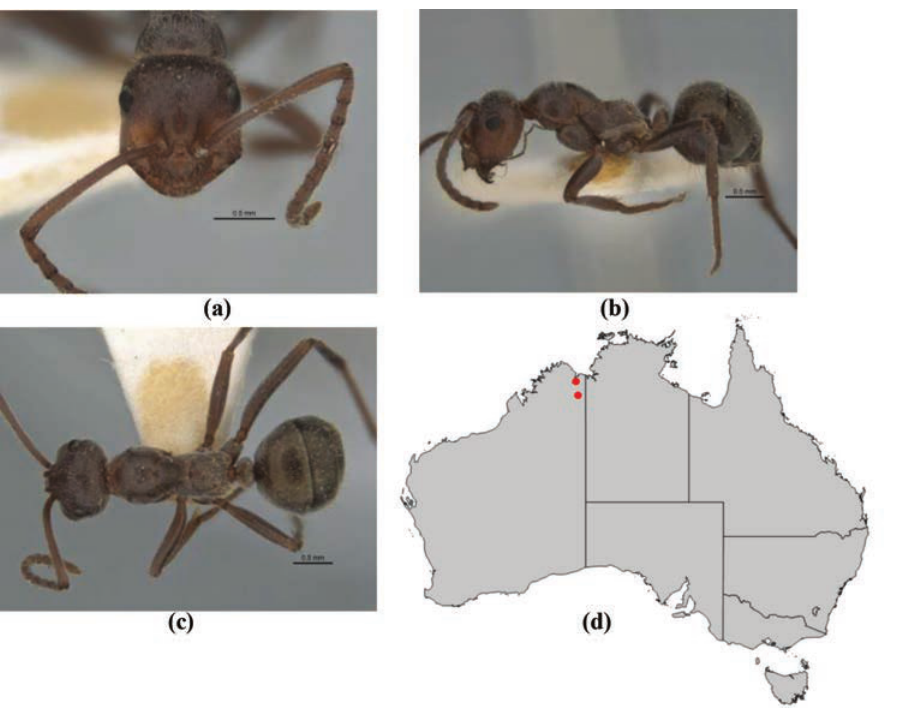
Figure 14. Melophorus griseus sp. n.: minor worker holotype (JDM32-004555) frons ( a ), profile ( b ) and dorsum ( c ); distribution map for the species ( d ). Low resolution scale bars: 0.5 mm ( a–c ). frons consisting of appressed pubescence, with many short, unmodified, erect setae. Eye moderate (eye length 0.20–0.49 length of side of head capsule); in full-face view, eyes set above midpoint of head capsule; in profile, eye set anteriad of midline of head capsule; eyes elliptical or slightly reniform. In full-face view, frontal carinae straight, divergent posteriad; frontal lobes straight, elevated. Anteromedial clypeal margin nar- rowly convex and protruding, clypeal midpoint distinctly notched; clypeal psammo- phore set at or just above anterior clypeal margin; palp formula 6,4. Five mandibular teeth in minor worker; mandibles triangular, weakly incurved; third mandibular tooth distinctly shorter than apical tooth and teeth numbers two and four; masticatory mar- gin of mandibles approximately vertical or weakly oblique. Mesosoma . Integument of pronotum, mesonotum and mesopleuron matt with indistinct shagreenate sculp- ture throughout; anterior mesosoma in profile broadly convex; appearance of erect pronotal setae short, (i.e., longest erect setae shorter than length of eye) and unmodi- fied; in profile, metanotal groove shallow, broadly V or U-shaped; propodeum matt or with a weak sheen and indistinctly shagreenate; propodeum smoothly rounded or with indistinct angle; propodeal dorsum and declivity confluent; erect propodeal setae present and abundant (greater than 12); appressed propodeal setulae long and closely aligned, creating pubescence; propodeal spiracle situated at least twice its width